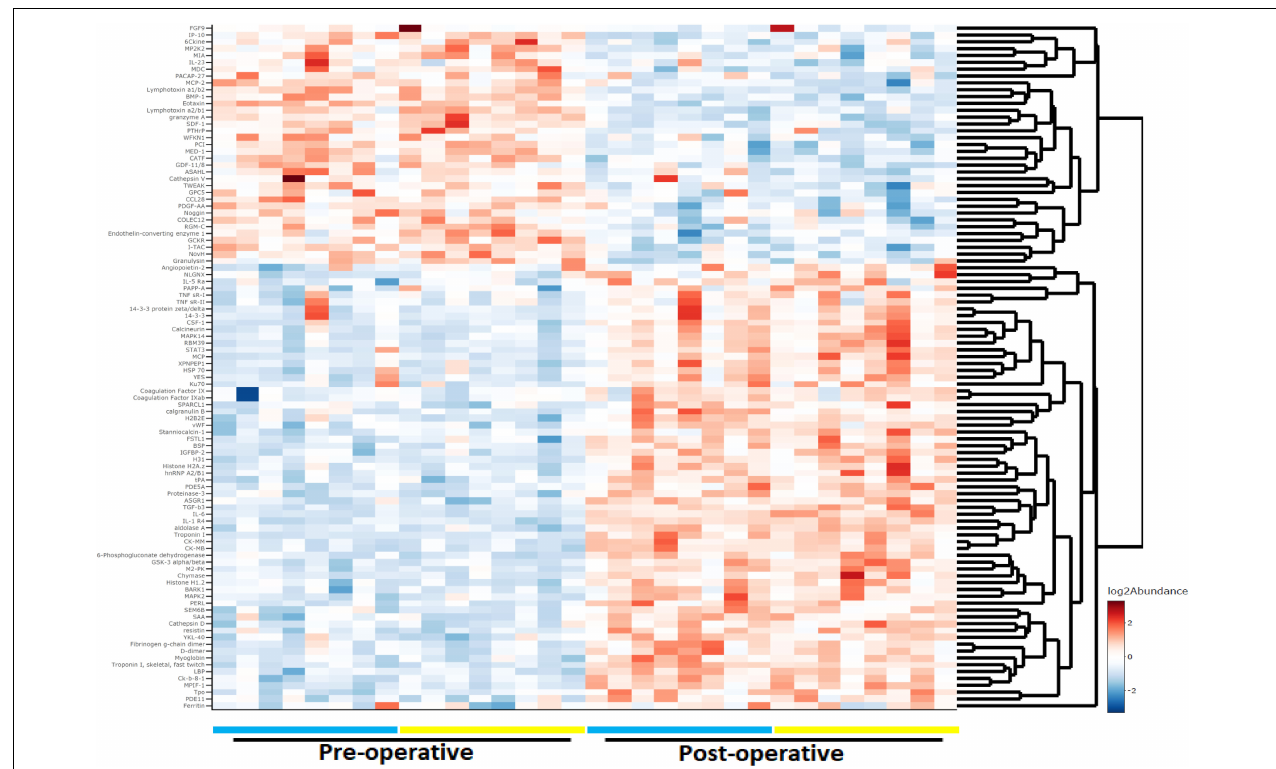
FIGURE 1 | Heat map and dendrogram of preoperative and 24-h postoperative proteomes. The top 100 proteins with the most significant change ( p adj < 3e10 − 6 ) at 24 h after surgery with cardiac bypass are listed. Patients with ( n = 8) and without ( n = 8) postoperative delirium (POD) are represented by yellow and blue bars,